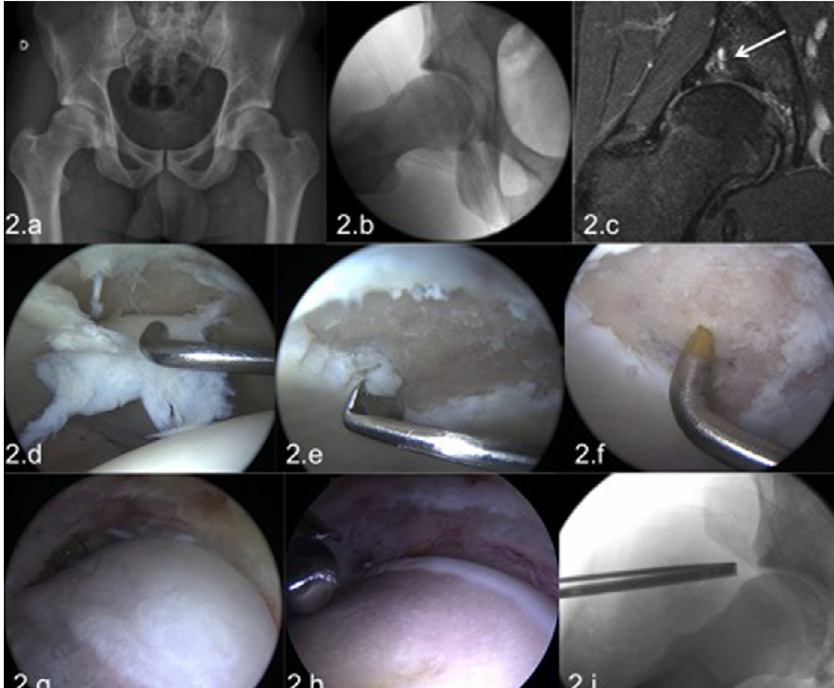
Figure 2. Male patient, 23 years old, medical student and amateur rugby player with sports-related pain in the right hip. The radiology demonstrated a FAI with a significant CAM deformity without significant joint space narrowing (2a, 2b). MRI showed a labral injury, a focal chondral lesion with subchondral cysts, and subchondral edema (2c). In spite of these ominous imaging signs given his young age and no other signs of osteoarthritis, hip arthroscopy was performed. At the arthroscopy an extensive full-thickness chondral lesion was found in the load-bearing surface of the acetabulum (2d); no femoral head cartilage lesions were present. The chondral lesion was treated by abrasive chondroplasty (2e) and microfractures (2f). In the peripheral compartment the extensive femoral bump (2g) was resected (2h). Intraoperative dynamic testing at the end of the femoroplasty demonstrated absence of impingement; the axial radiography demonstrated a satisfactory correction of the cam deformity (2i). Nevertheless after this arthroscopic repair, the future of this joint is uncertain with a high risk to progress to osteoarthritis in this young